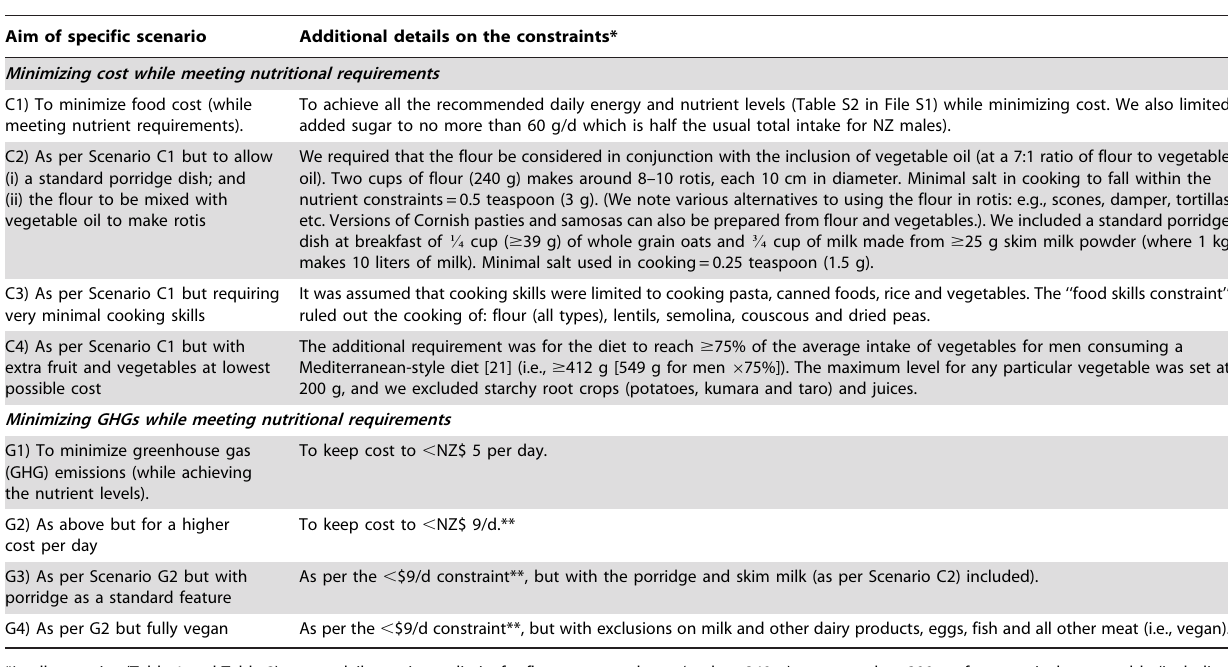
Table 1. Specific scenarios used for the optimization modeling with a focus on achieving nutrient levels at lowest cost along with low GHG